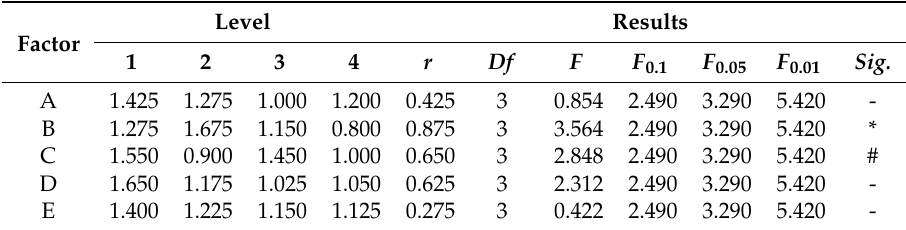
Table 7. Analysis of influencing factors on flexural